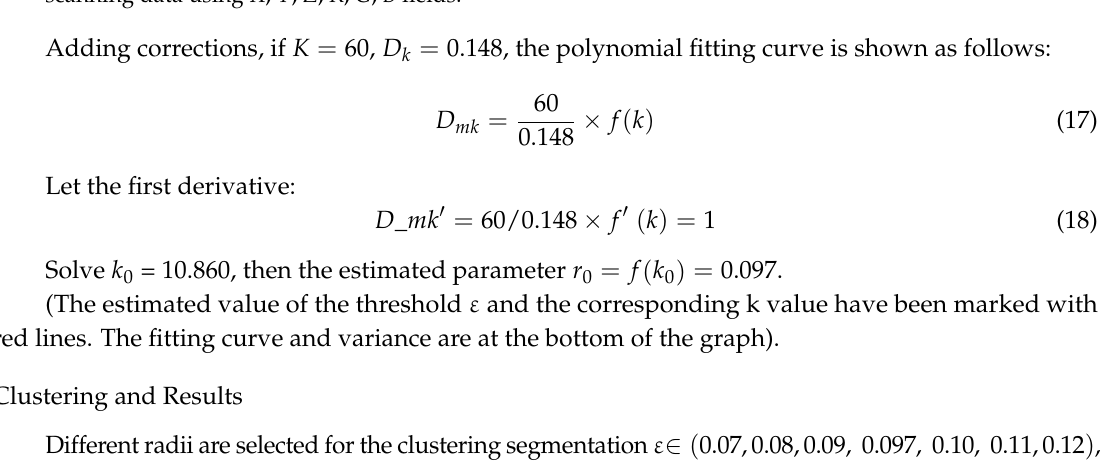
Table 3. The segmentation results using different thresholds for airborne laser scanning data using X , Y , Z , R, G, B fields.